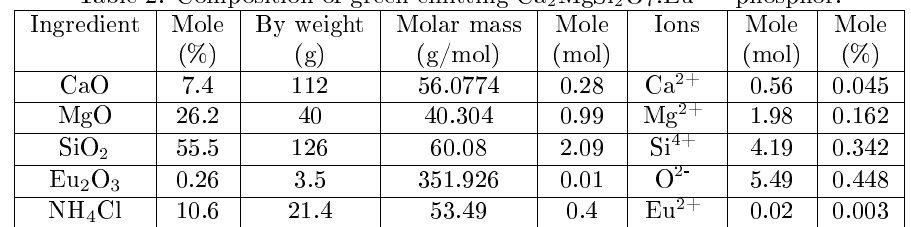
Table 2. Composition of green-emitting Ca 2 MgSi 2 O 7 :Eu 2+ phosphor.